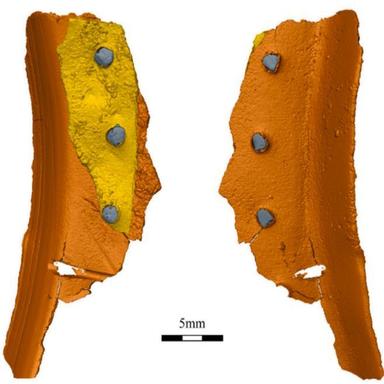
CT image of Han dynasty basin fragment CML 37 with a repair patch, which was fixed on the outer surface with rivets entered from the patch.